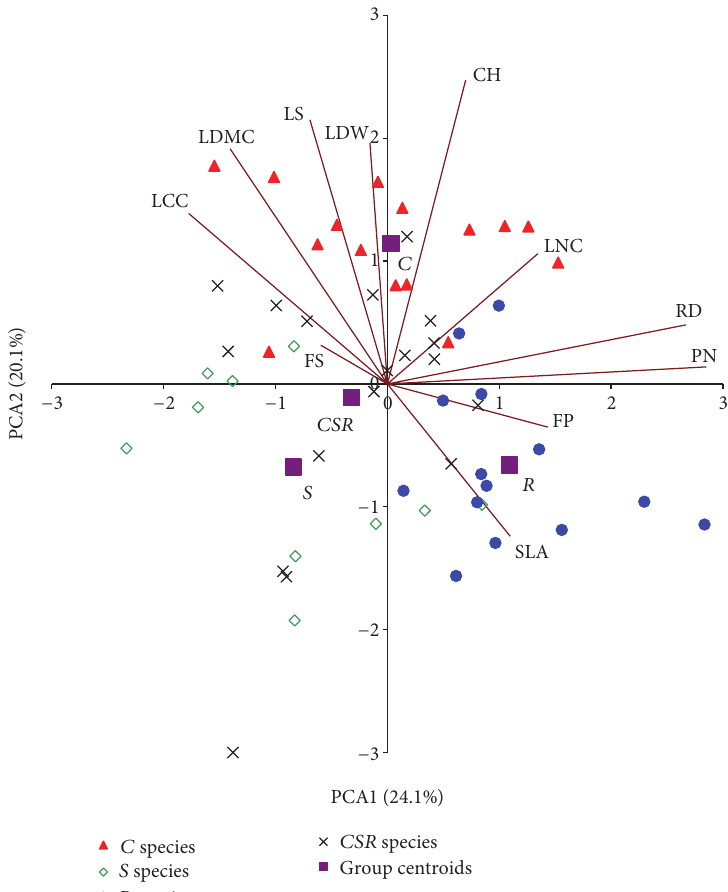
Figure 2: Principal component analysis (PCA) ordination of species of different plant functional types. Predictors morphological and physiological traits that differed significantly for different groups of species (Table 2). Lines show a correlation between parameters and PCA axes. 𝐶 , species competitors; 𝑆 , stress-tolerators; 𝑅 , ruderals; 𝐶𝑆𝑅 , intermediate species. Squares with letters are centroids of groups of